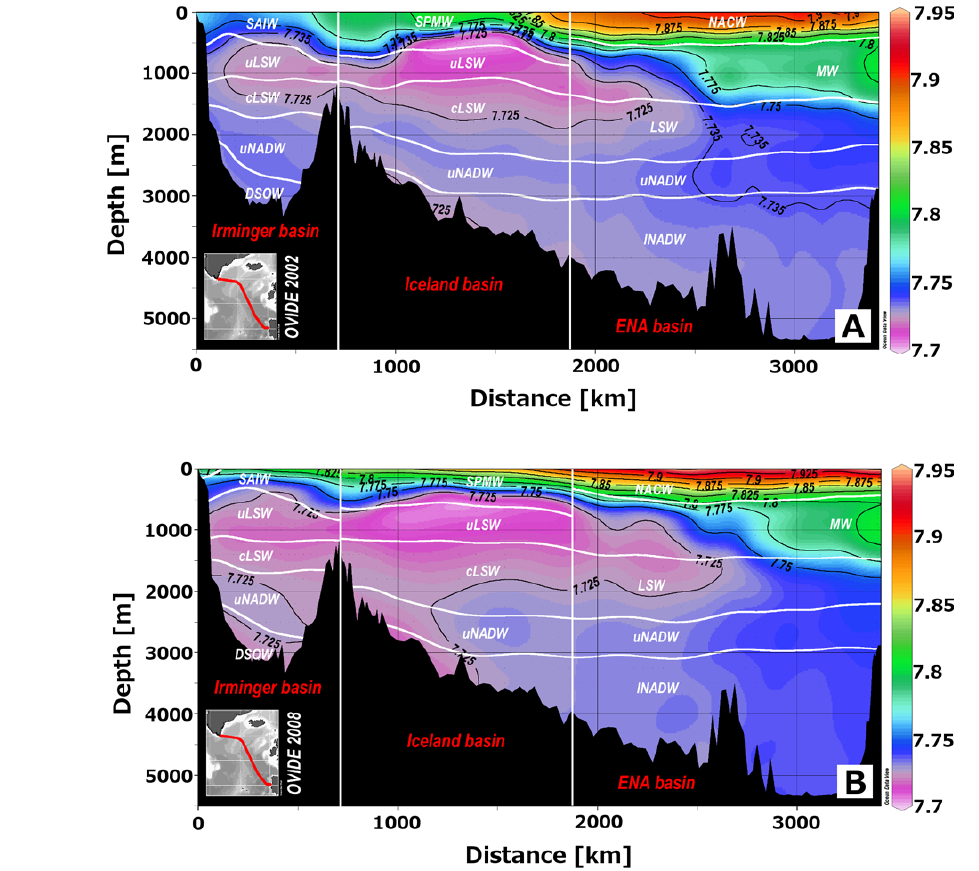
Figure 4. Spatial and temporal change of seawater pH measured across the North Atlantic Subpolar Gyre between Greenland and the Iberian Peninsula. The vertical distribution of pH followed the anticipated natural distribution, with higher pH in surface waters and lower pH in deep waters. A comparison of pH values measured in 2002 (a) and 2008 (b) revealed an overall decrease in seawater pH in intermediate and deep waters. This acidification was most evident in water depths between 1000 and 2000m, where over the years the water layer with pH values below 7.725 had thickened several-fold (Vázquez-Rodríguez et al.,